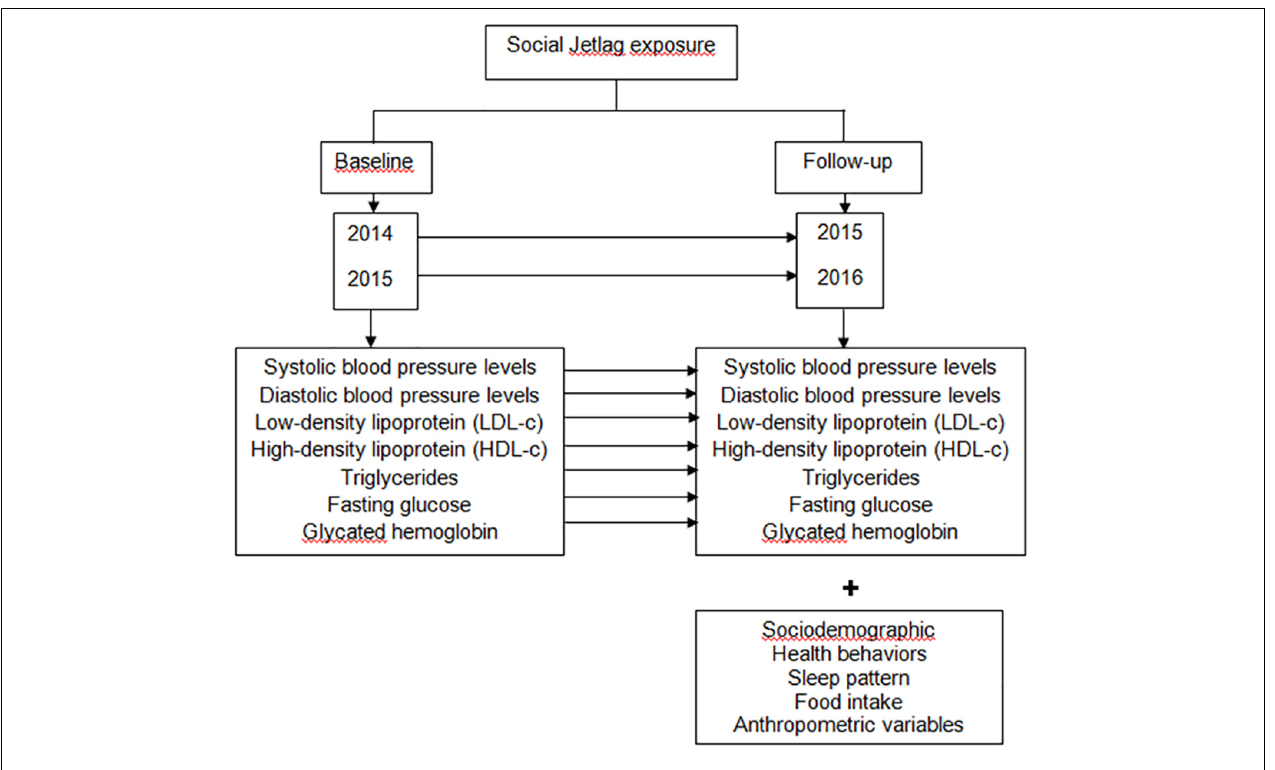
FIGURE 1 | Methods to examine the influence of SJL on metabolic parameters and blood pressure (BP) over a year of follow-up. In this retrospective and longitudinal study the degree of exposure to SJL was assessed at the time of follow-up and the metabolic parameters were compared in two different times. Our assessments were carried out from September 2015 to July 2016; and in the present study we included only those patients who had in the medical record metabolic parameters referring to the year prior to the interview and anthropometric evaluation. Thus, the evaluation of the metabolic parameters was as follows: for the individuals interviewed in 2015, the metabolic parameters for the year 2014 were retrieved from the electronic medical record, with a 12-month interval; and for individuals interviewed in 2016, the metabolic parameters for 2015 were retrieved from the electronic medical record, with a 12-month interval. SJL, social jetlag.